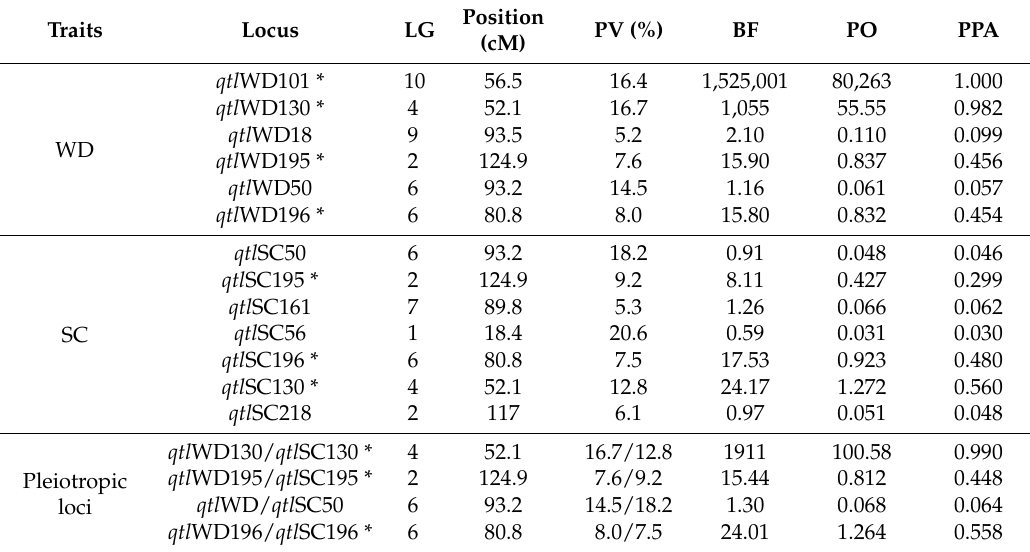
Table 4. Summary of loci associated with wood density (WD) and slenderness coefficient (SC) using a unified mixed linear model and Bayesian regression analysis, measured in 17-year-old trees of E. cladocalyx in arid